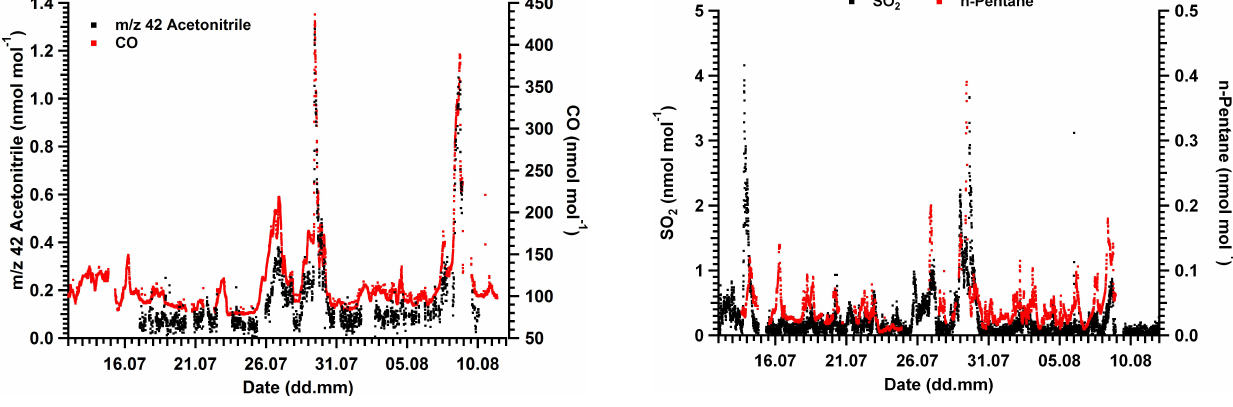
Fig. 7. Acetonitrile (CH 3 CN) and Carbon monoxide (CO) mixing ratios (5min averages) for the duration of HUMPPA-COPEC cam- paign measured at the HUMPPA tower.